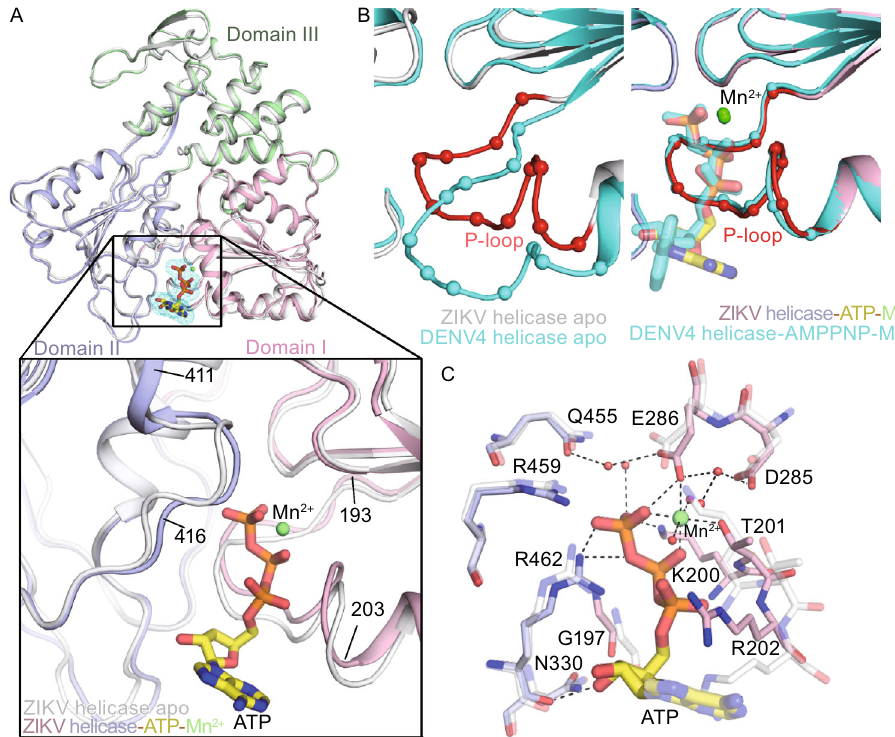
Figure 2. Structure of the ZIKV helicase in complex with ATP/Mn 2+ . (A) Overall fold of ZIKV helicases, with cartoon representation of apo form (white) overlaid to the complex (the three domains are colored respectively). The ATP is drawn as sticks and mesh; Mn 2+ as green sphere. A detailed comparison for the ATP binding sites of the two structures is depicted in the zoomed view below. (B) A close-up view of the NTPase active site. P-loops are represented by superimposition of the structures of ZIKV (white, with the P-loop highlighted in red) and DENV4 (cyan) apo-helicases in the left panel and their complexes in the right panel. The DENV4 helicase complex was bound to AMPPNP and Mn 2+ (PDB code 2JLR). (C) Interactions at NTPase active site by superposition of the ZIKV helicase complexed with ATP and Mn 2+ (solid) with its apo enzyme (semitransparent, PDB code